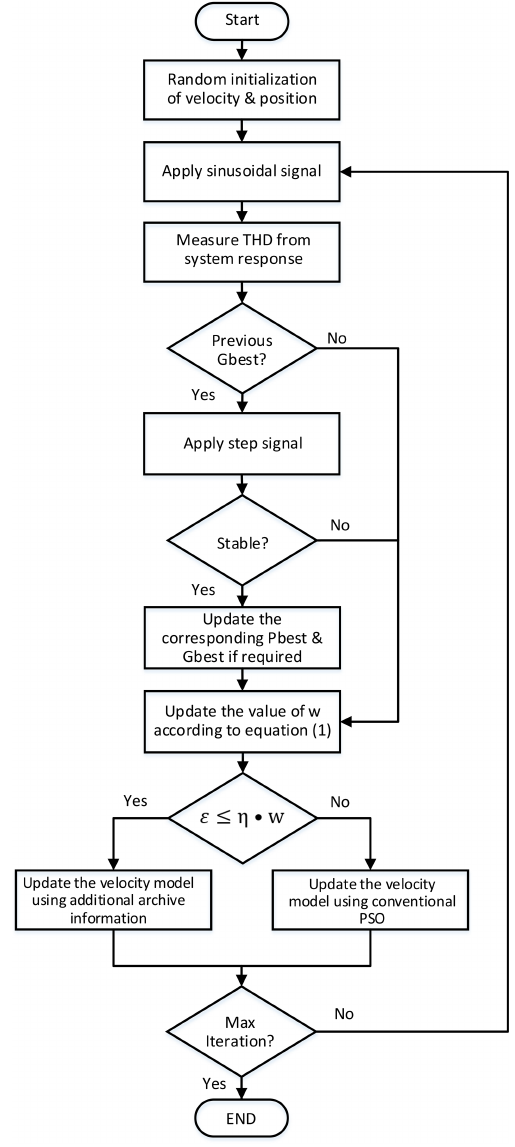
Figure 3. Flow chart of the proposed design